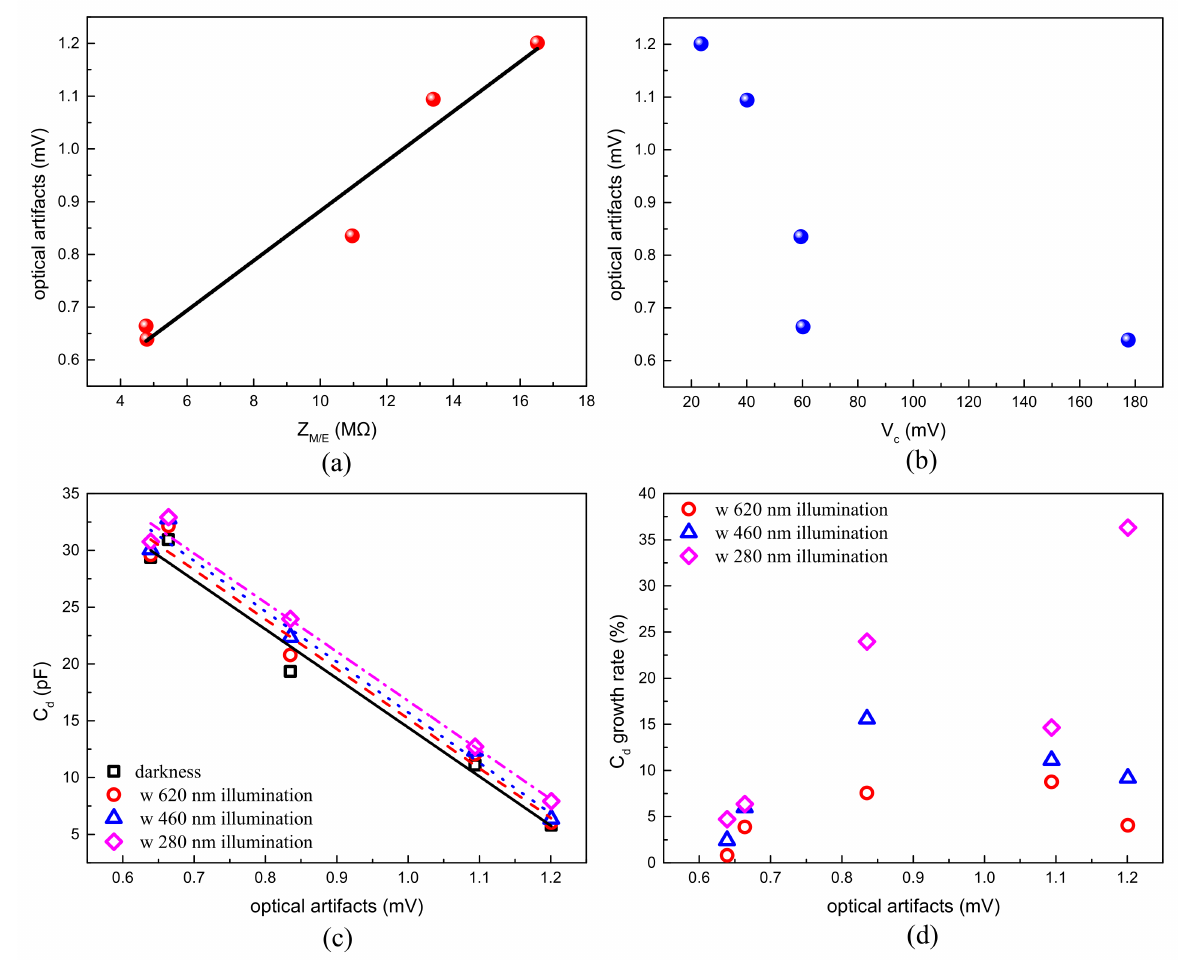
Figure 8. The correlation analyses between optical artifacts and ( a ) Z M/E , ( b ) the critical value V c , ( c ) C d and ( d ) the growth rate of C d ,